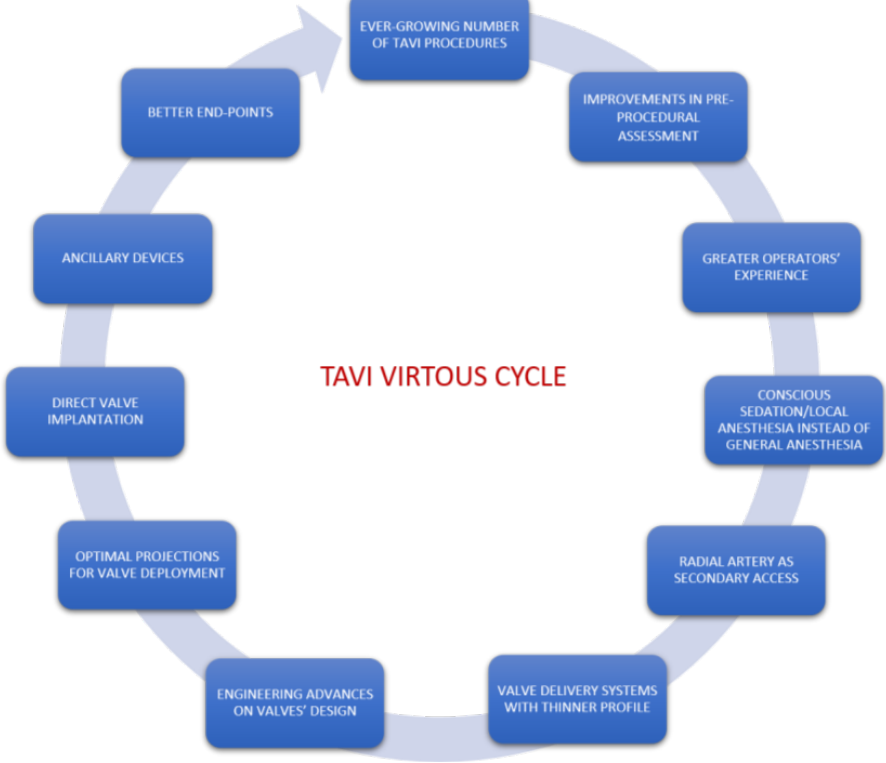
Figure 1. Transcatheter aortic valve implantation (TAVI) virtuous cycle generated by increased operators’ experience and improved technology.